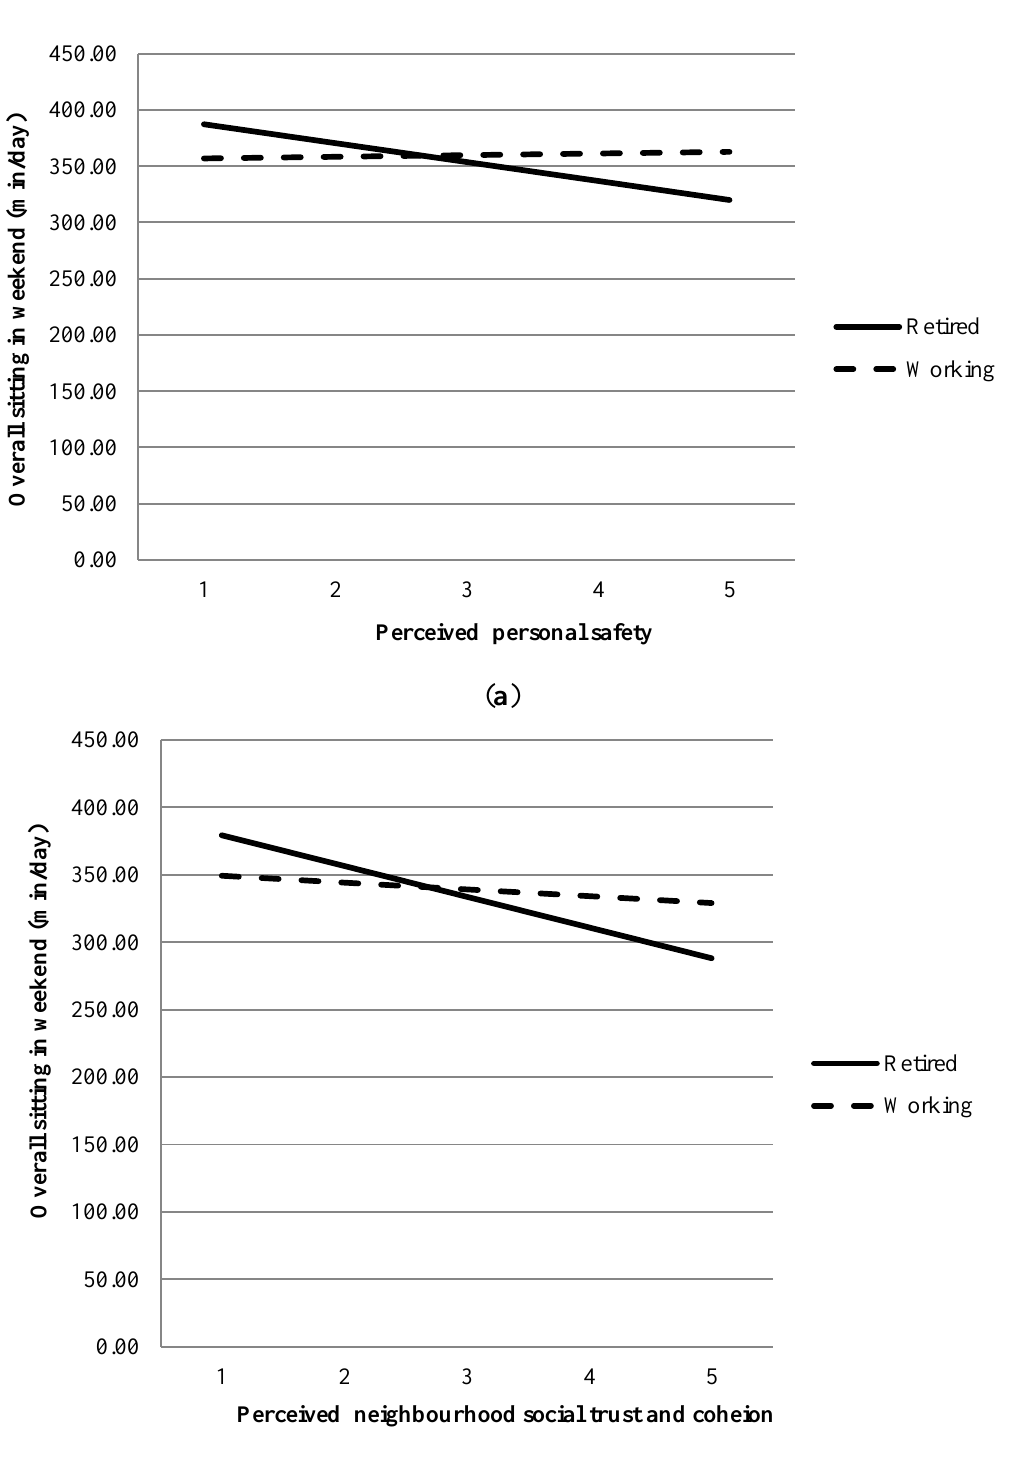
Figure 1. Moderation by retirement status for the bivariate relationship between social trust & cohesion ( a ), personal safety ( b ) and weekend day